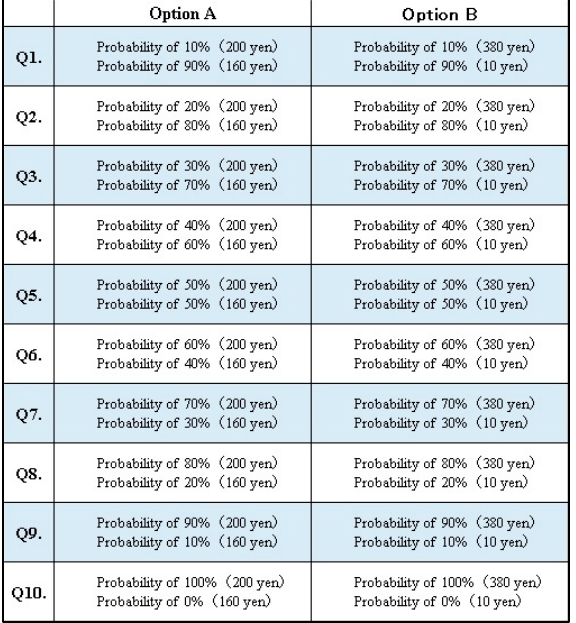
Figure A1. Choosing between Options A and B for Task 1.